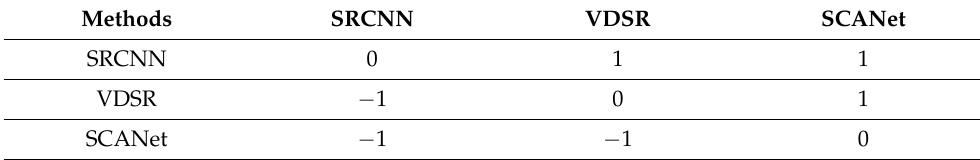
Table 4. Subjective quality comparisons with different no-reference image quality indicators.